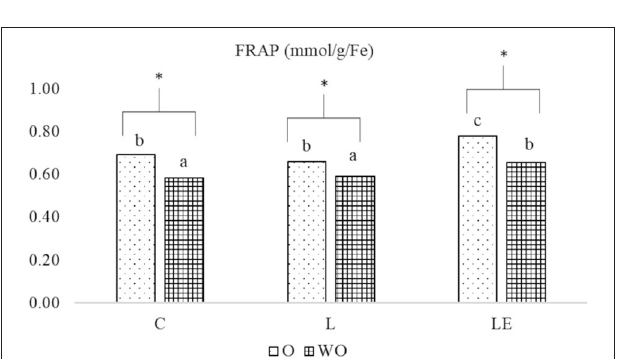
FIGURE 4 | Effect of experimental diets (C, L, and LE) on FRAP concentration in Marchigiana beef meat treated with (O) and without essential oils (WO) at 9 days of storage. Different letters on the top of the bars denote significant differences ( P < 0.05) between different dietary treatments (C, L, and LE). Asterisk denotes significant differences in the same group between the meat with (O) and without (WO) essential oils.